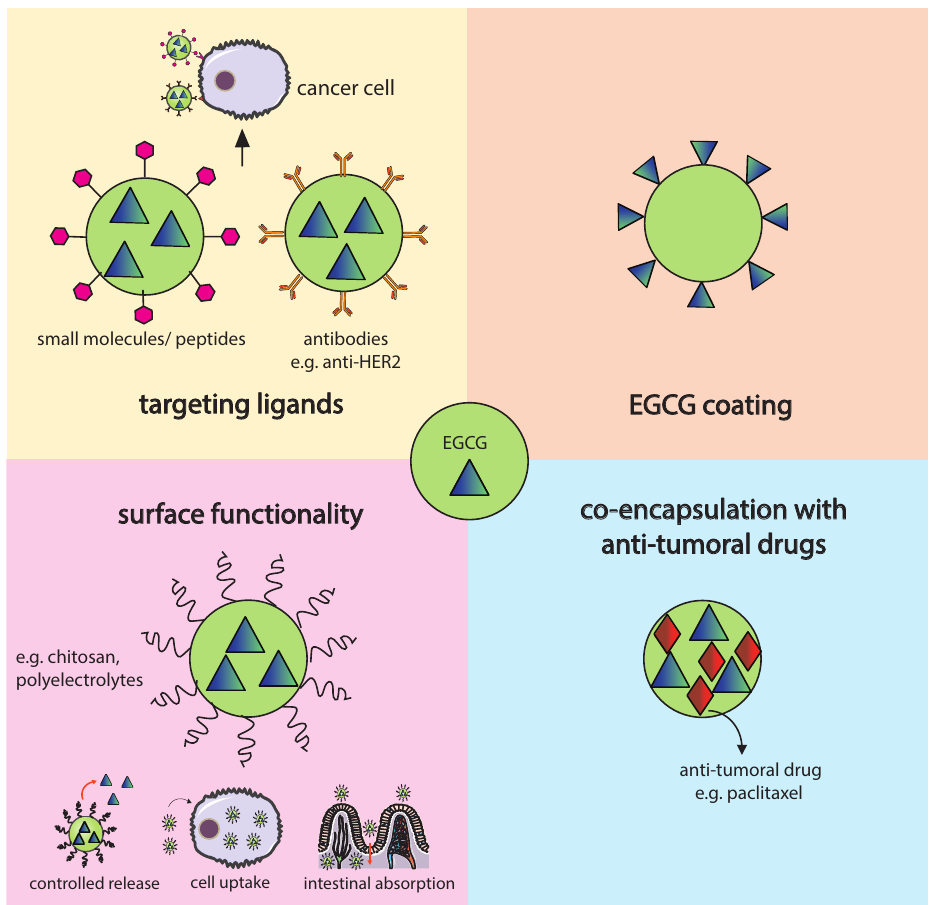
Figure 3. Summary of EGCG delivery approaches for cancer therapy reported in the literature: ( 1 ) incorporation of ligands (small molecules, peptides and antibodies) at the surface of the nanoparticle to target specific cancer cell receptors or antigens; ( 2 ) use of EGCG as a capping agent; ( 3 ) surface functionalization with specific polymers to enhance drug release properties, cell uptake and intestinal absorption; and ( 4 ) co-encapsulation with common cytostatic drugs such as